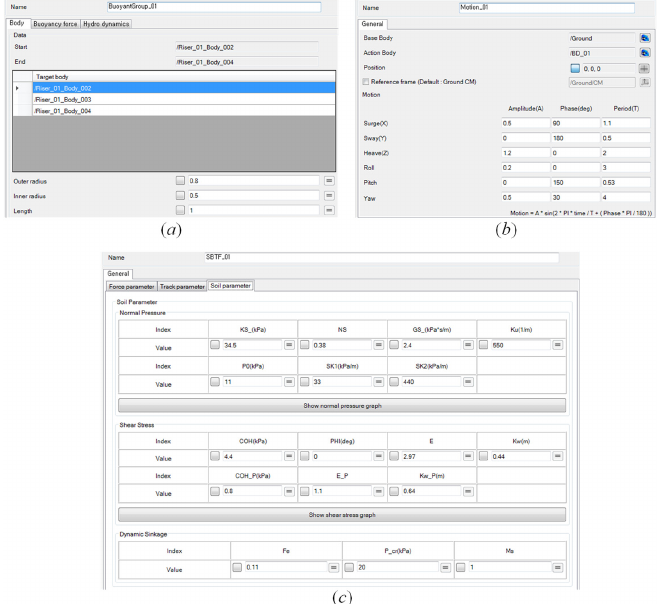
Figure 23. User interface of mechanical system modeler: ( a ) definition dialog for the shape of buoyancy module, ( b ) definition dialog for the motion of mining vessel, ( c ) input dialog for parameters of the soil model.